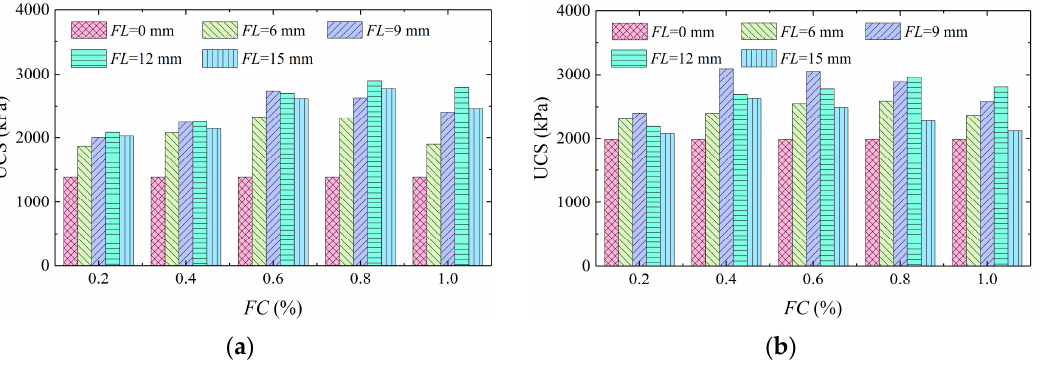
Figure 6. Histogram of unconfined compressive strength versus fiber content ( a ) ρ d = 1.5 g/cm 3 ; and ( b ) ρ d = 1.6 g/cm 3.